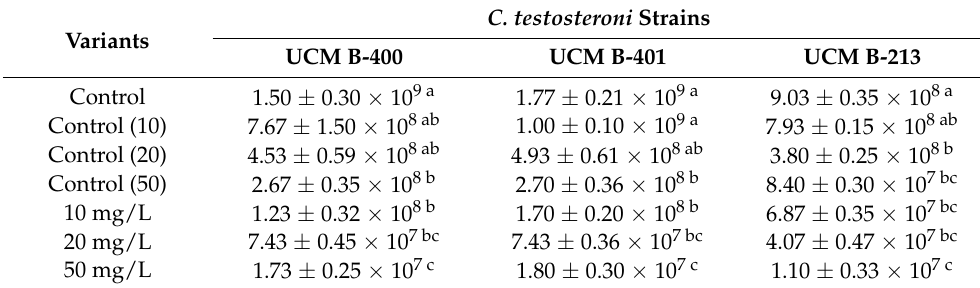
Table 2. C. testosteroni cells titer after adding HCB to the culture medium (CFU/mL). Variants